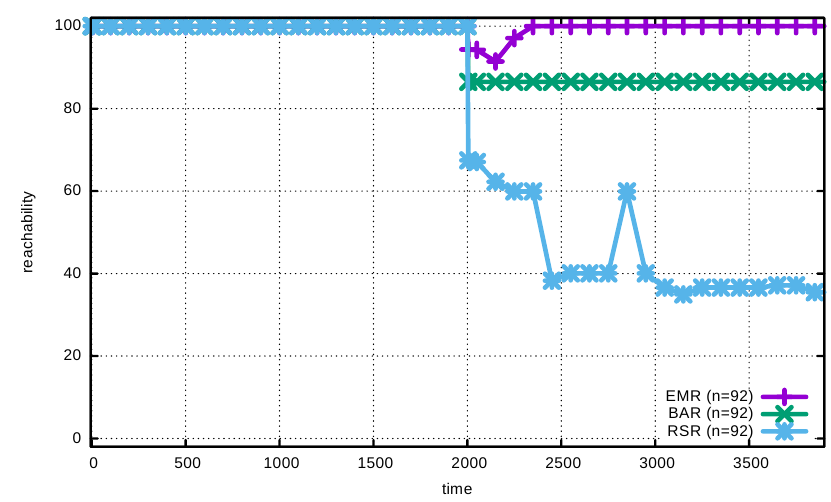
Fig. 14: Comparison of reachability before and after the self-healing process (a single run).